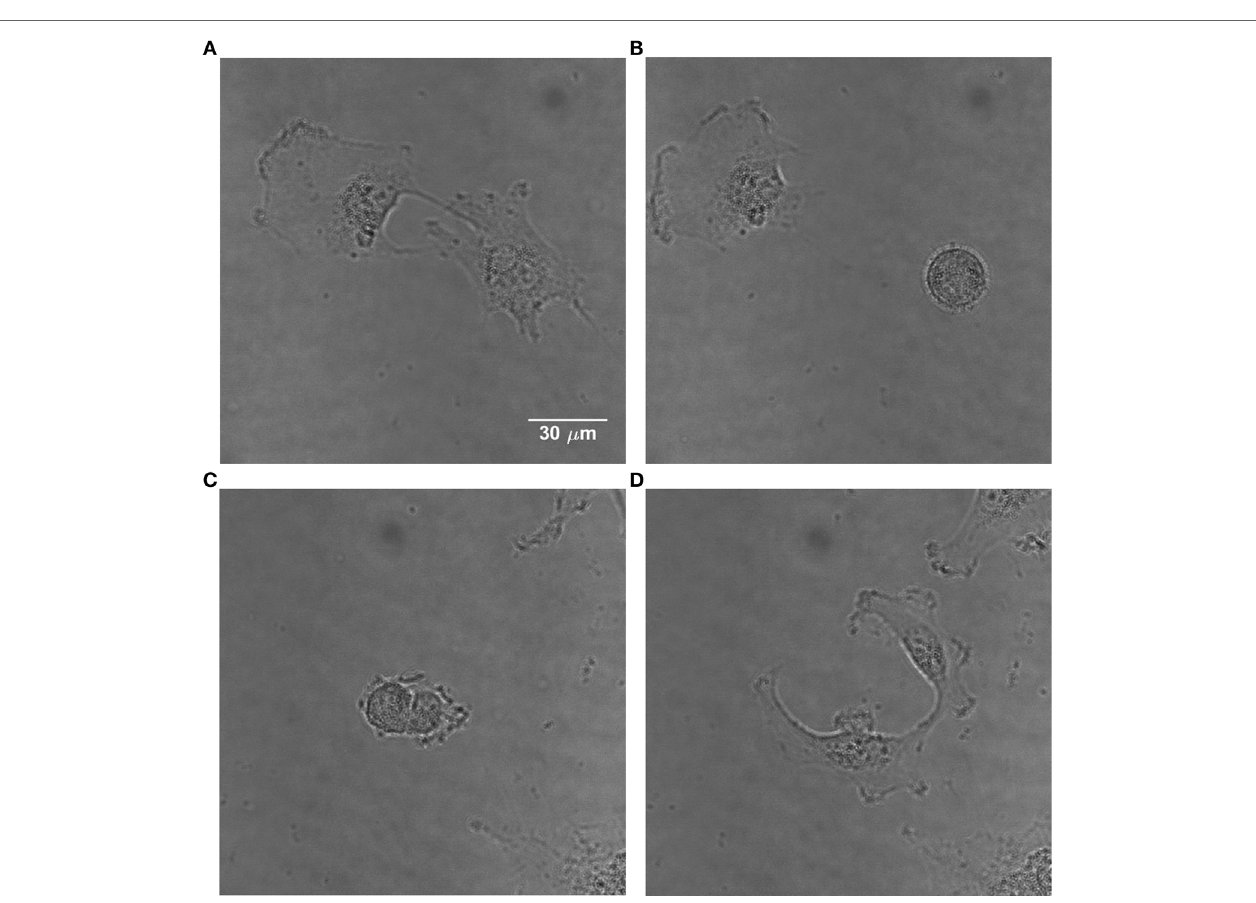
FIGURe 2 | time-lapse images of U251 cells showing the change in morphology of a dividing cell . (A) Non-dividing adherent U251 cells. (B) One of them divides, obtaining a characteristic round shape. (C) The dividing cell starts the separation process. (d) The cell has divided and the daughter cells become